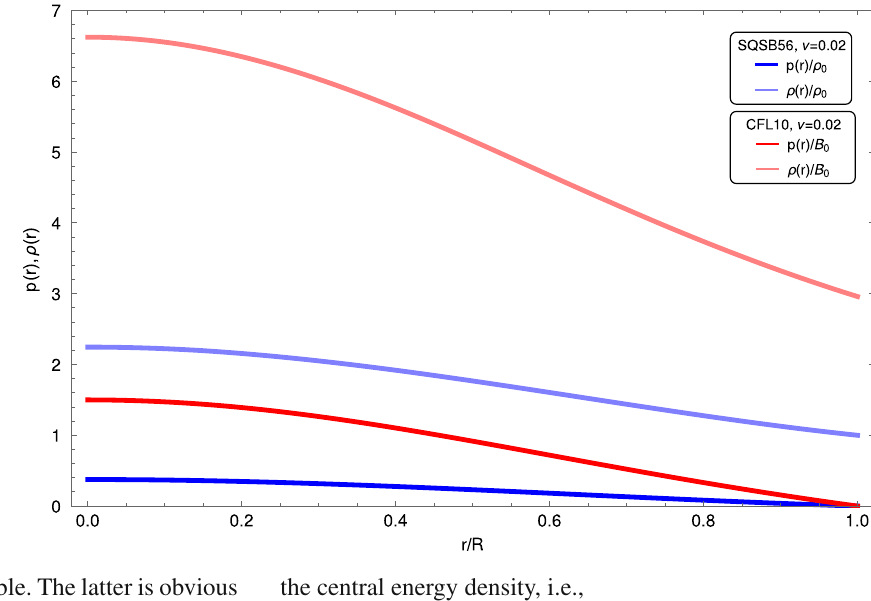
Fig. 4 Normalized pressure and energy density vs normalized radial coordinate r / R for ν = 0 . 02 for the models SQSB56 (blue) and CFL10